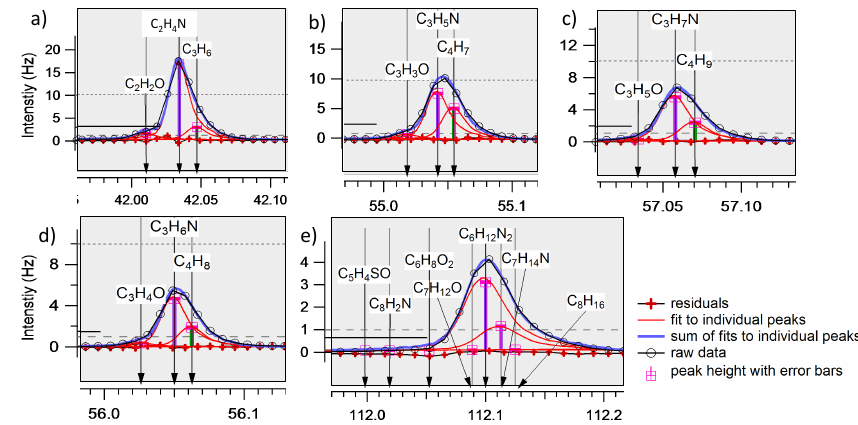
Fig. 12. Selection of high-resolution marker ion fragments for the AA-OA PMF factor in the difference spectrum.